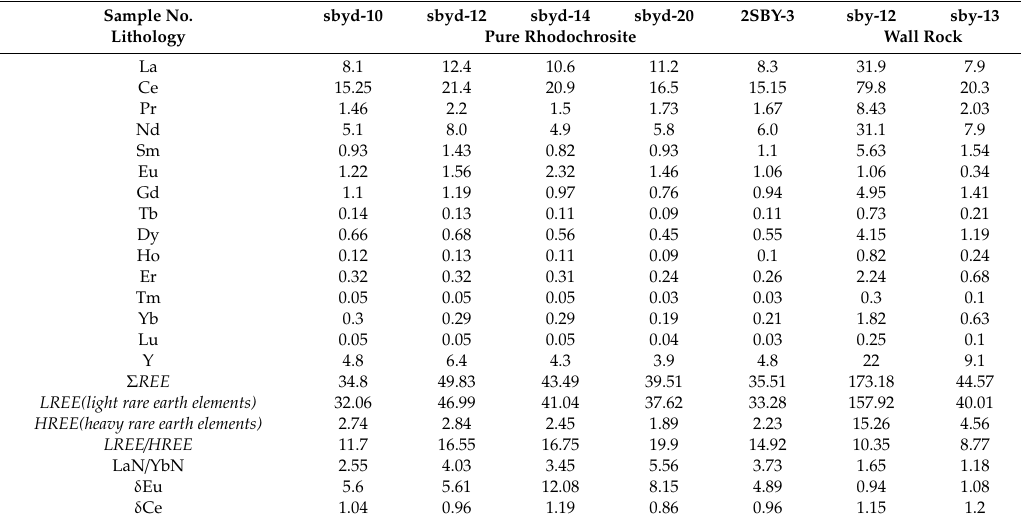
Table 5. REE (ppm) composition of the pure rhodochrosite (primary ore) and wall rocks from the Sanbao deposit. Sample No.